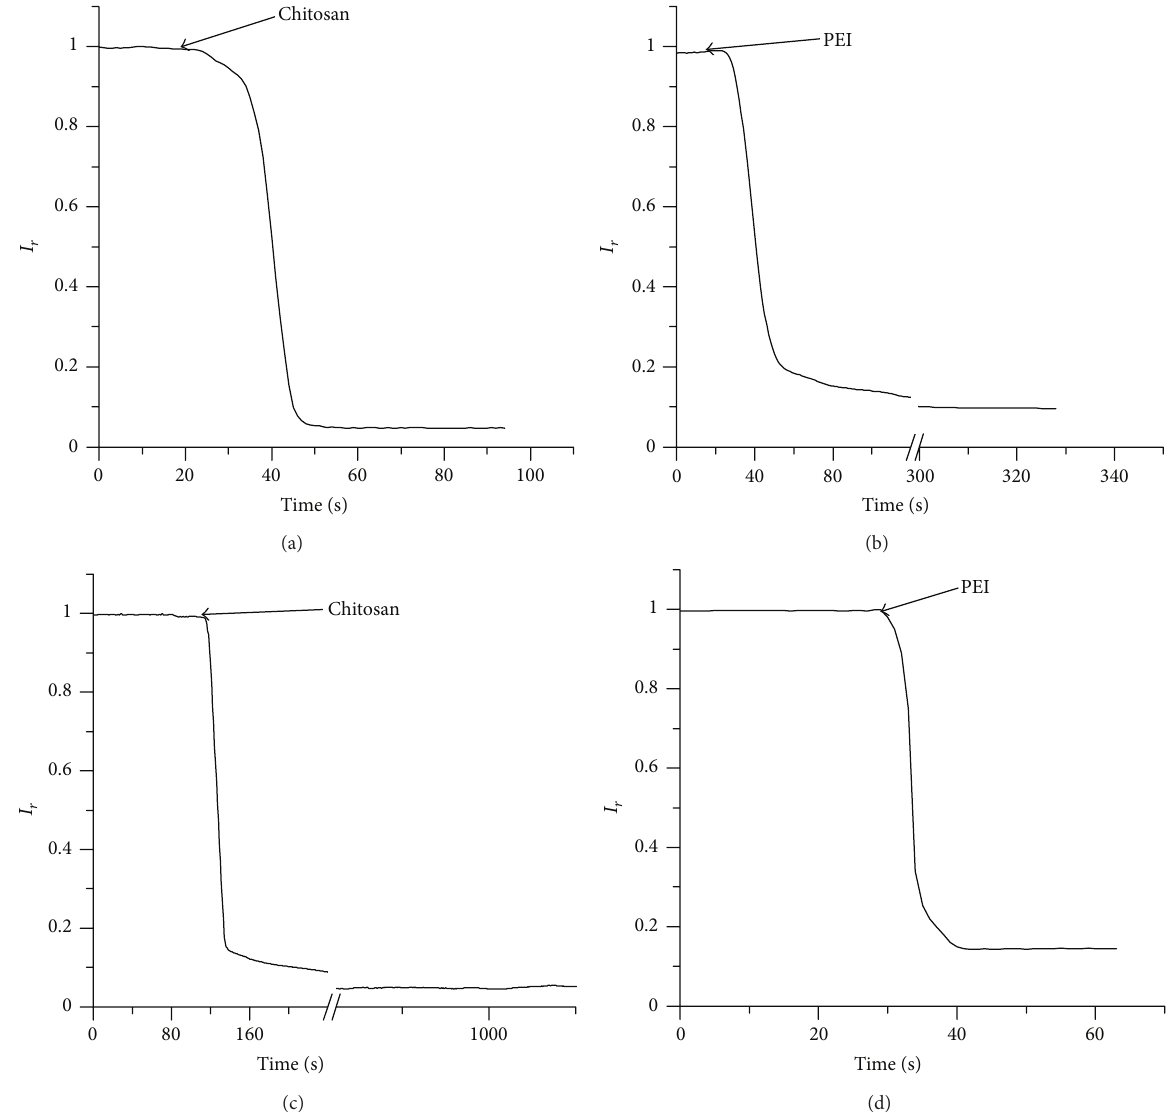
Figure 1: Trans addition of chitosan (8 𝜇 M final concentration) and PEI (4 𝜇 M final concentration) inhibits the macroscopic conductance of lysenin channels inserted into Aso-based ((a) and (b)) and neutral ((c) and (d))